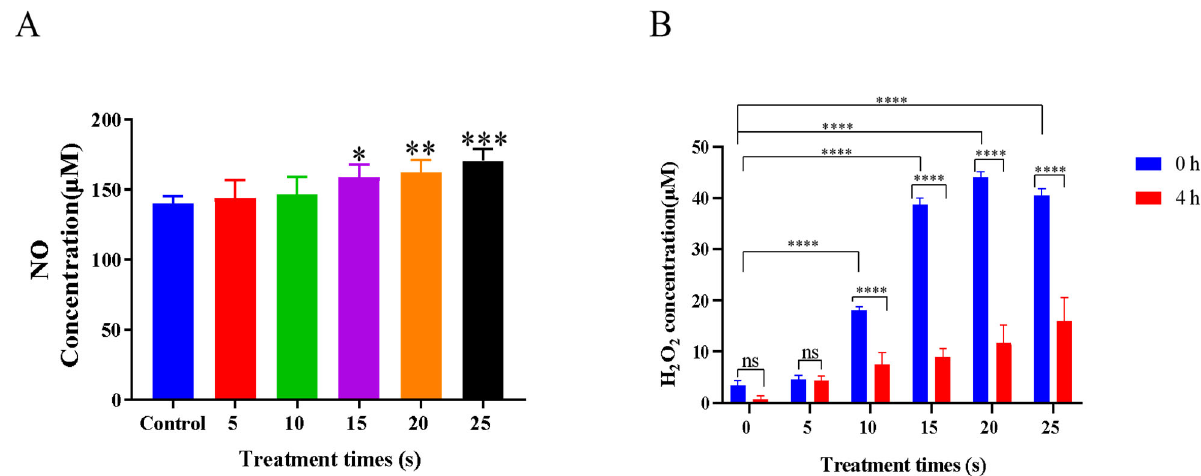
Figure 2. Extracellular NO and H 2 O 2 content. ( A ) The concentration of NO in the cell culture medium after NTP treatment for 0, 5, 10, 15, 20 and 25 s. ( B ) The concentration of H 2 O 2 in the cell culture medium for 0 h and 4 h after NTP treatment for 0, 5, 10, 15, 20, and 25 s. Data represent the mean ± SD of three independent experiments . “ns” was not considered statistically significant. * p < 0.05, ** p < 0.01, *** p < 0.001, **** p < 0.0001 with ANOVA compared with the control.